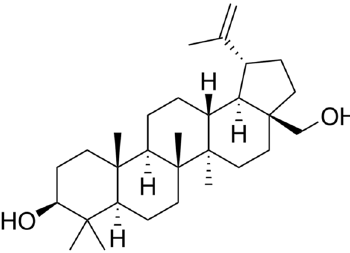
Figure 4. Chemical structure of AN-10 fraction (C 30 H 50 O 2 ).